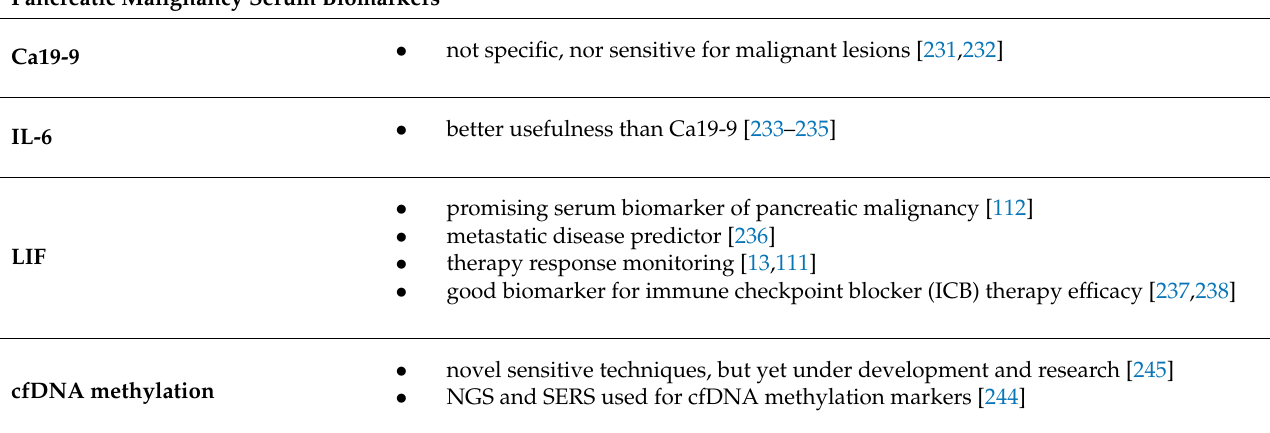
Table 4. New early serum diagnostic methods. Ca19-9, carbohydrate antigen; IL-6, interleukin 6; LIF, leukemia inhibitory factor; cfDNA, cell-free DNA; CTC, circulating tumor cells; SERS, surface- enhanced Raman spectroscopy; NGS, next-generation